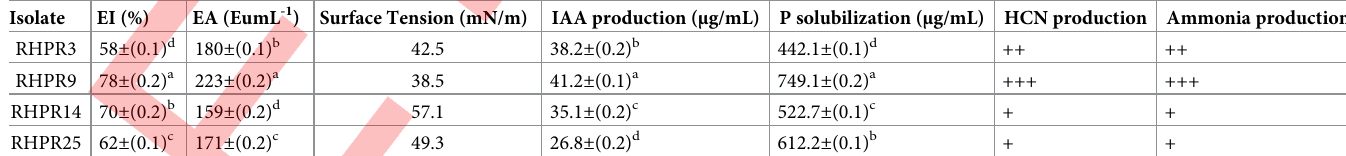
Table 1. Screening for biosurfactant production and plant growth promotion by Streptomyces spp. Isolate EI